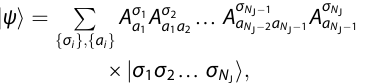
P N J θ ¼ i i ¼ 1 J